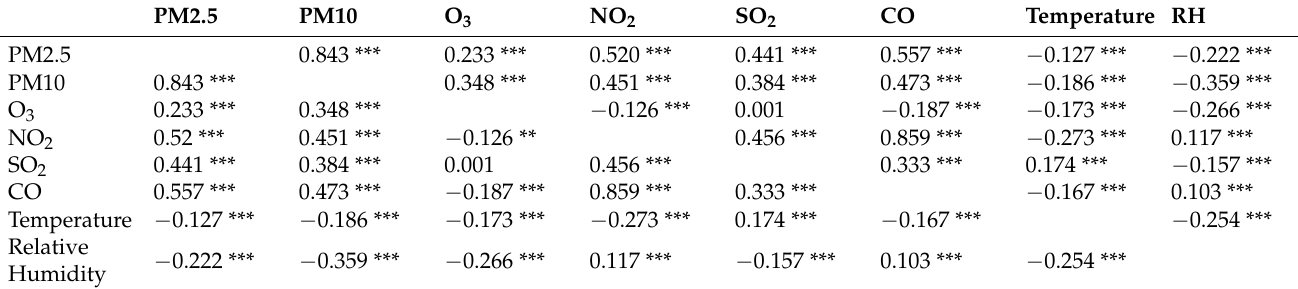
Table 2. Correlation analysis of all air pollutants and meteorological